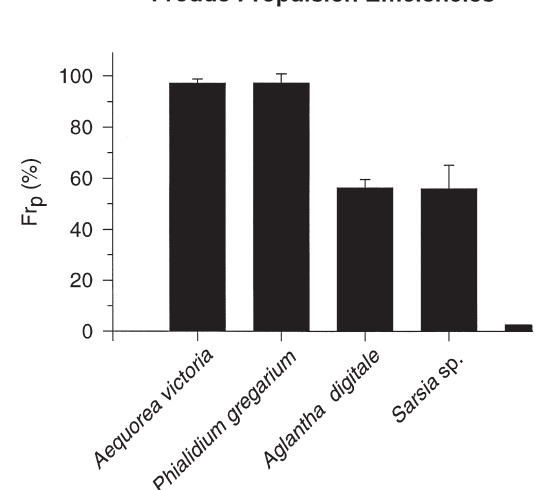
) of hydromedusae. p